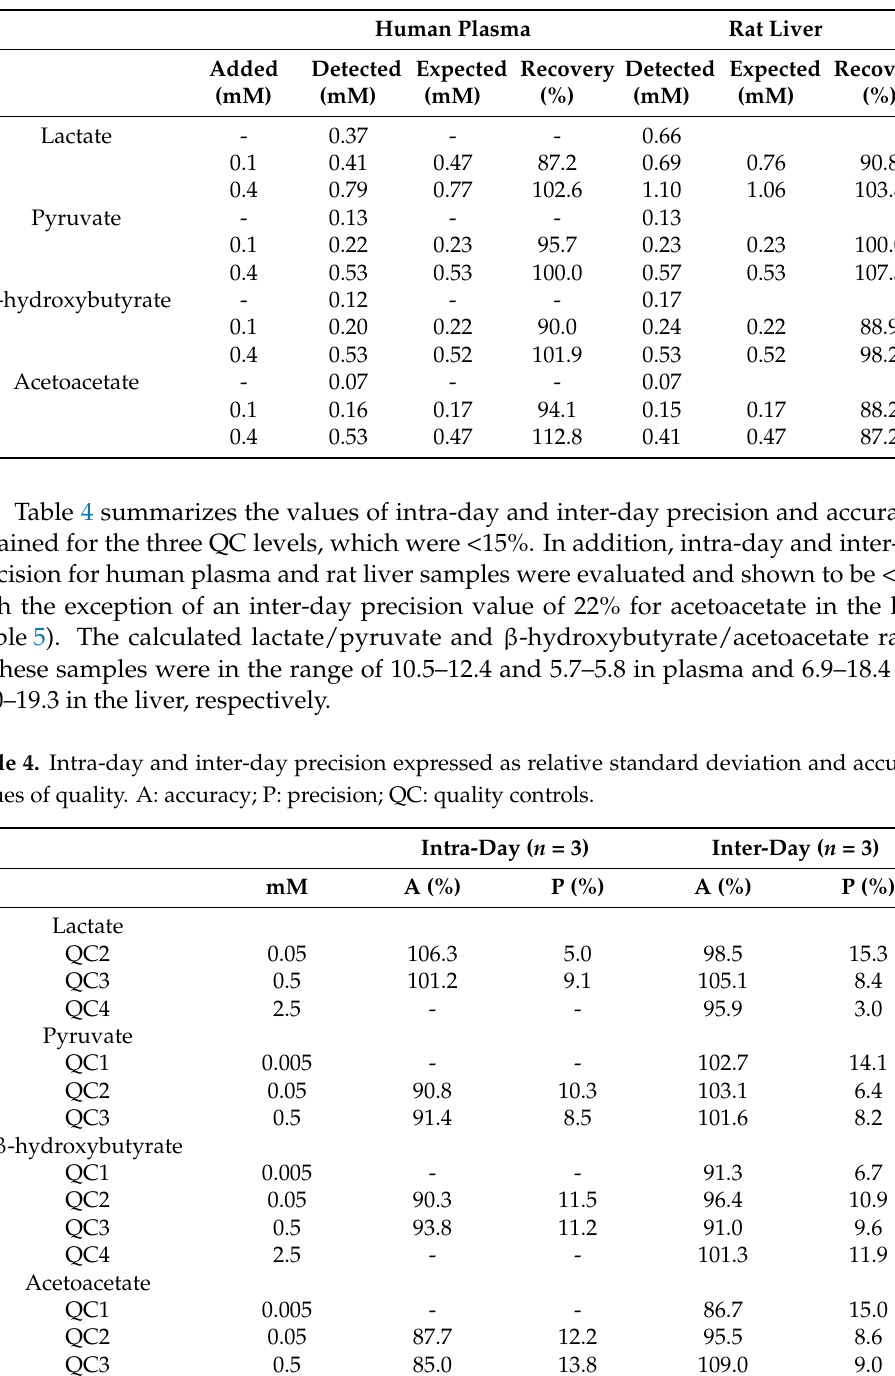
Table 3. Recovery of added metabolites in human plasma and rat liver samples.